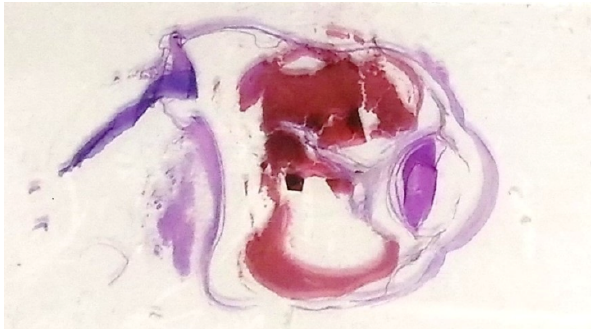
Figure 3: Histologic section of the right eye showing hyphema and posterior synechiae, completely closed angles, and total retinal detachment and massive subretinal